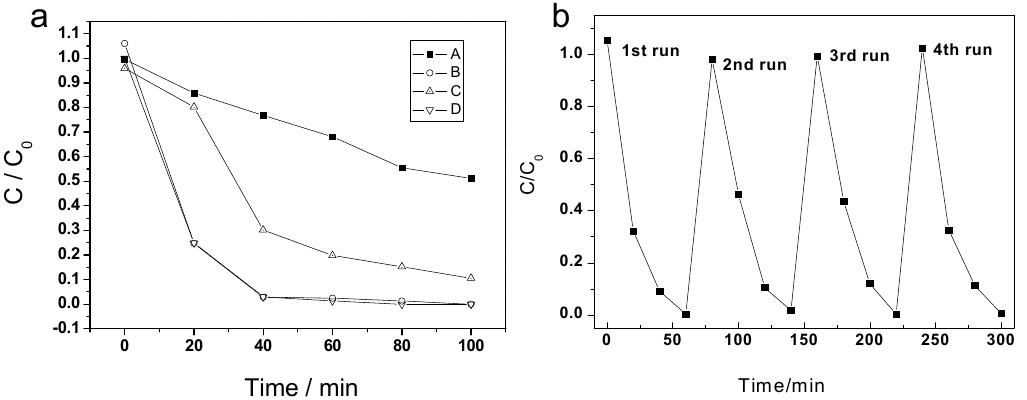
Figure 7. ( a ) Photocatalytic degradation of RB under UV-light irradiation, A—blank control, B—P25, C—TiO 2 -550, D—TiO 2 -800. ( b ) Recycling test for RB degradation over TiO 2 -800.